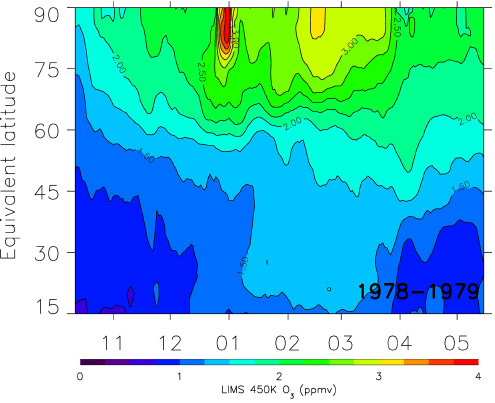
Figure 19. As in Fig. 16, but for PV vs. equivalent latitude at 450K (CI is 3.2 units).